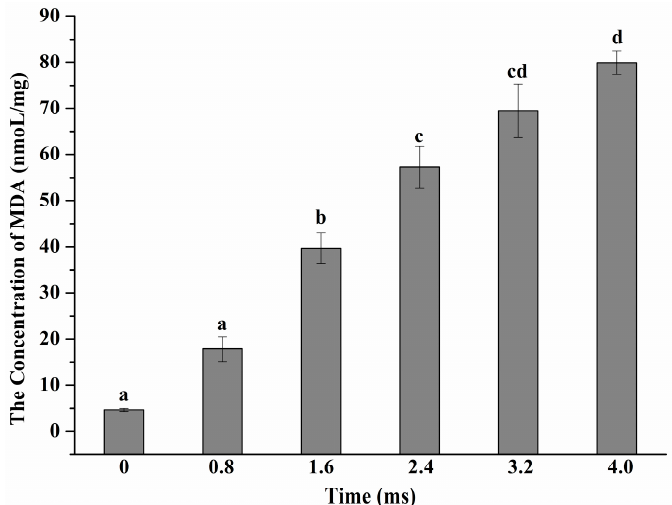
Figure 3. The alterations of content of malondialdehyde of S. typhimurium after PEF treatments at 25 kV/cm for 0–4 ms. Different letters indicate the significant difference ( p < 0.05).